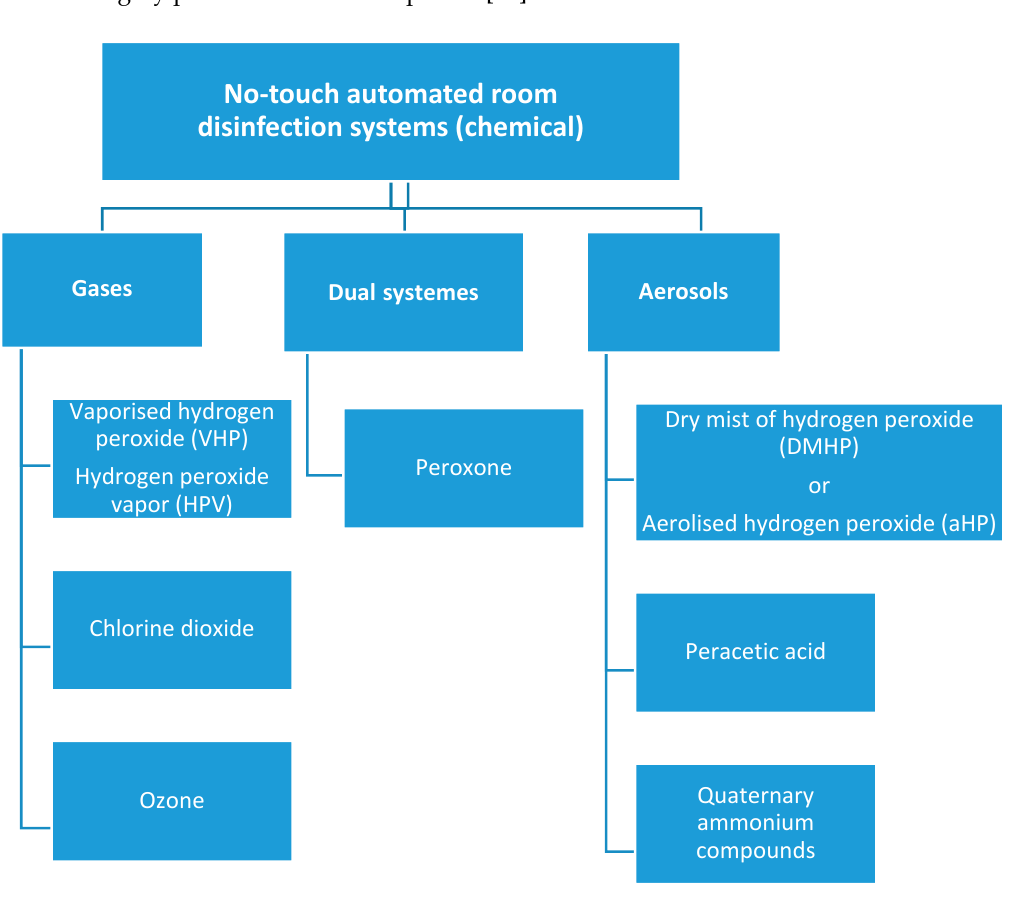
Figure 1. Chemical no-touch room disinfection systems.